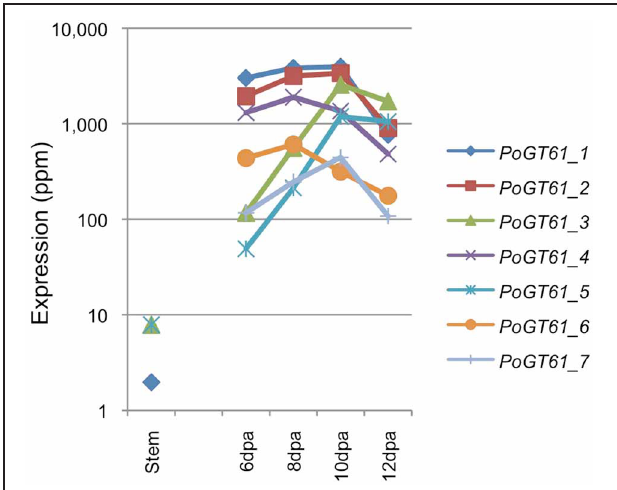
FIGURE 4 | Expression levels of glycosyltransferase family 61 genes in psyllium in stem and mucilaginous layers.